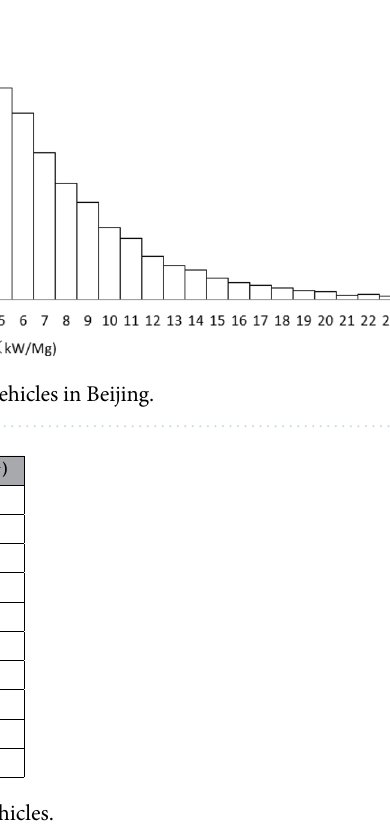
Table 1. Bin partitions of VSP for light-duty gasoline vehicles.